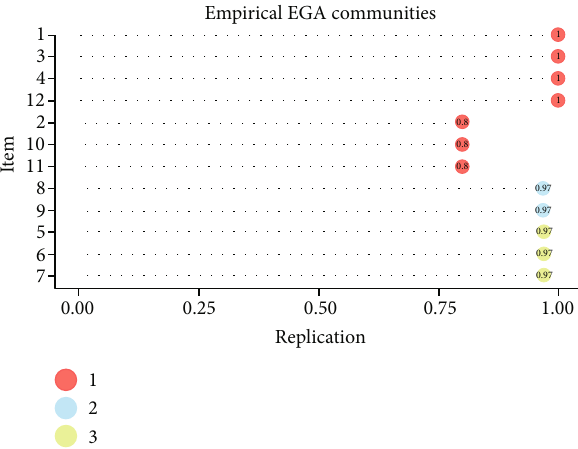
Table 2: Grouping of comorbidities according to the EGA.